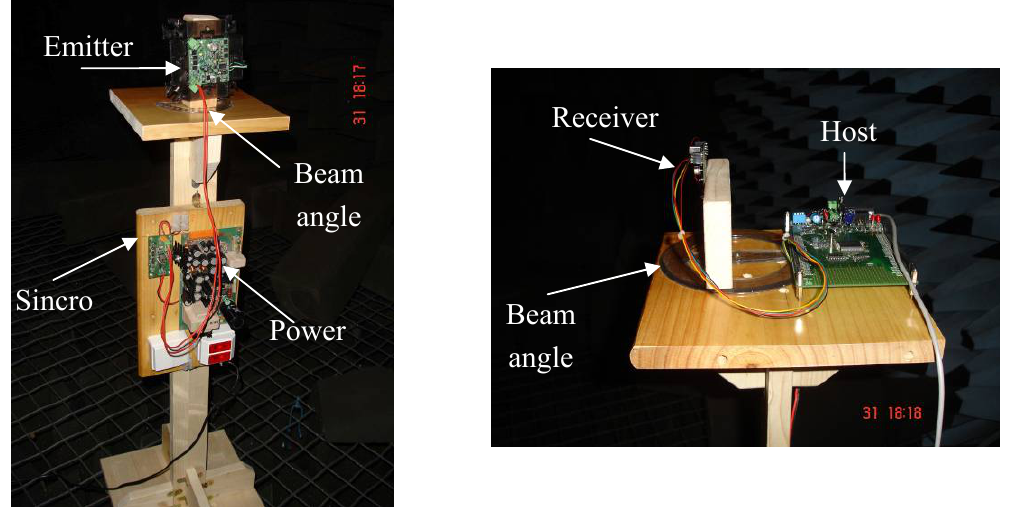
Figure 25 . Emitter and